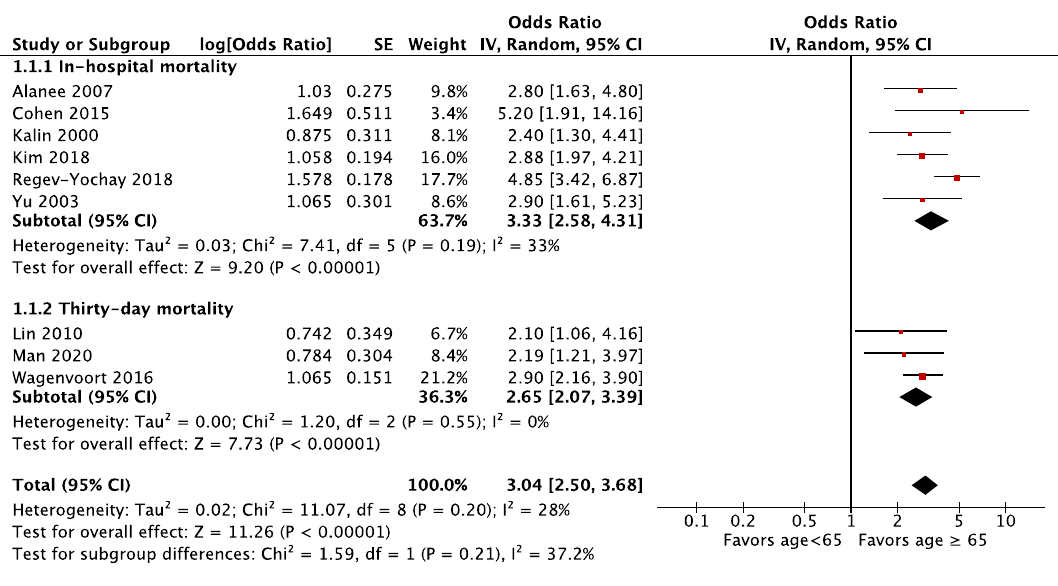
Figure 2. Risk factor of Age > 64